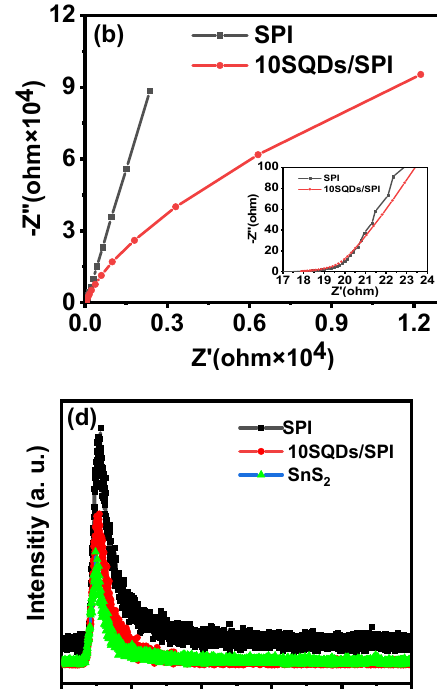
Figure 7. ( a ) Comparison of the photocatalytic degradation of MO over different catalysts under full arc light ( λ > 300 nm). The initial point at t = 0 was used as C 0 . ( b ) Photocatalytic degradation rate of SPI, SQDs and SQDs/SPI composites.